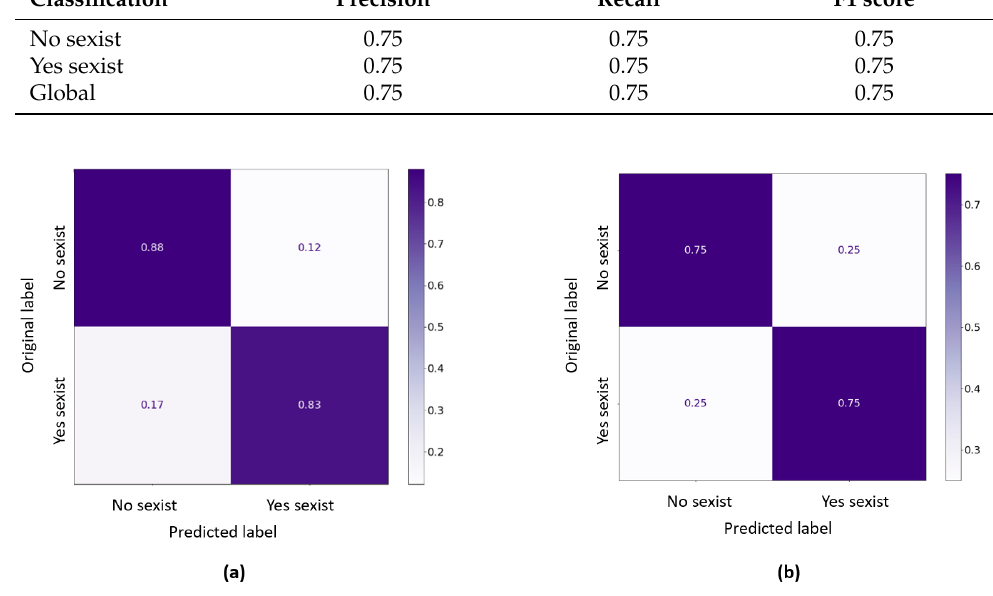
Figure 4. Normalized confusion matrix ( a ) of the training set and ( b ) of the test